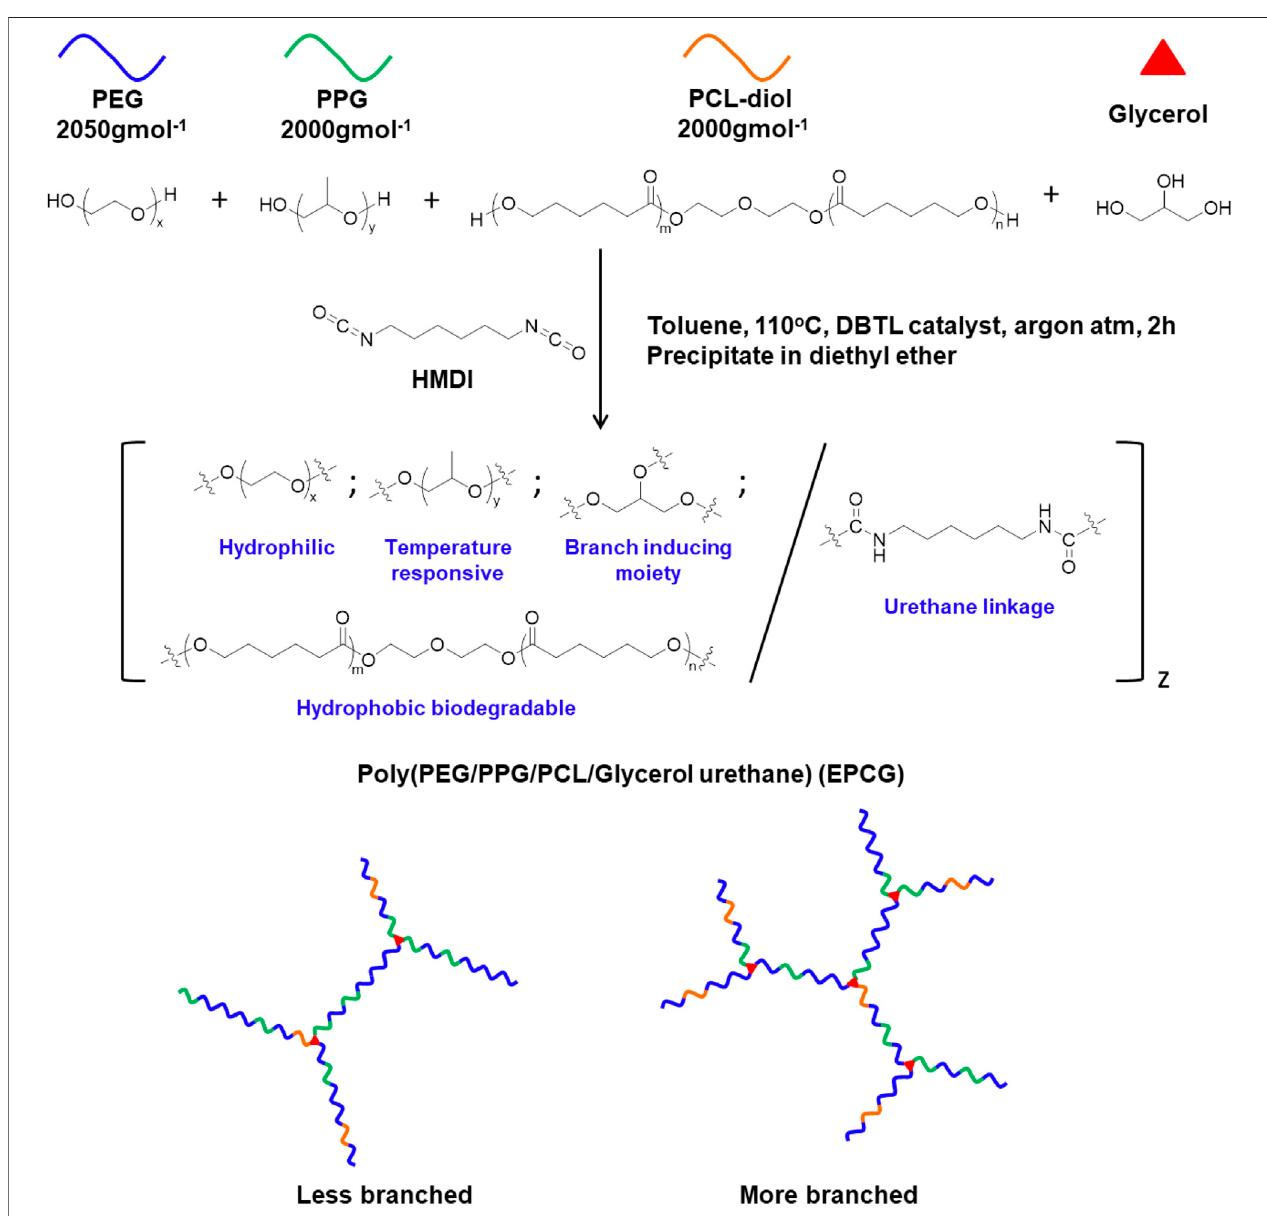
FIGURE 1 | Schematic representation of the synthesis route of poly (PEG/PPG/PCL/Glycerol urethane) (EPCG) branched thermogelling copolymers.